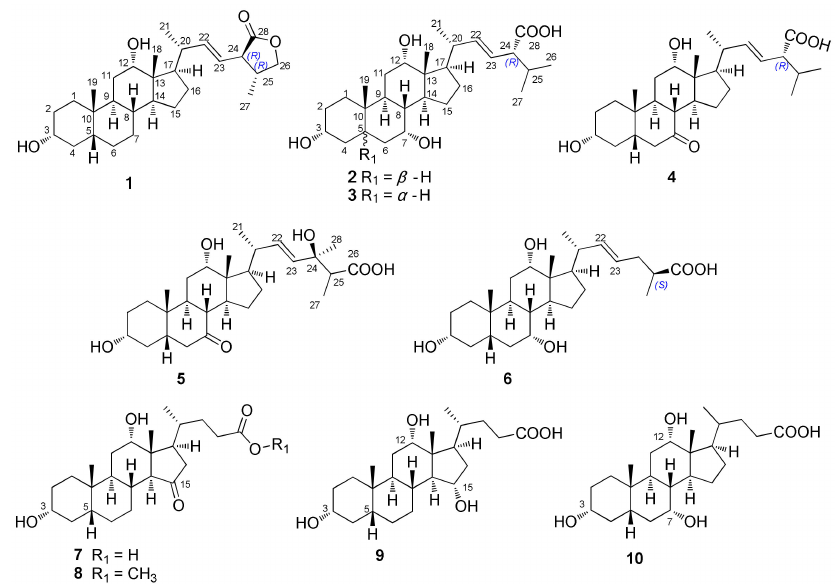
Figure 1. Chemical structures of the compounds isolated from Bufo bufo gargarizans ( 1 – 10 ): 1 – 5 were unusual C 28 bile acids possessing a double bond at C-22, 6 was an unreported C 27 bile acid with a ∆ 22 double bond, 7 – 8 were rarely known C 24 bile acids with a 15-oxygenated fragment, and 9 – 10 were two known bile